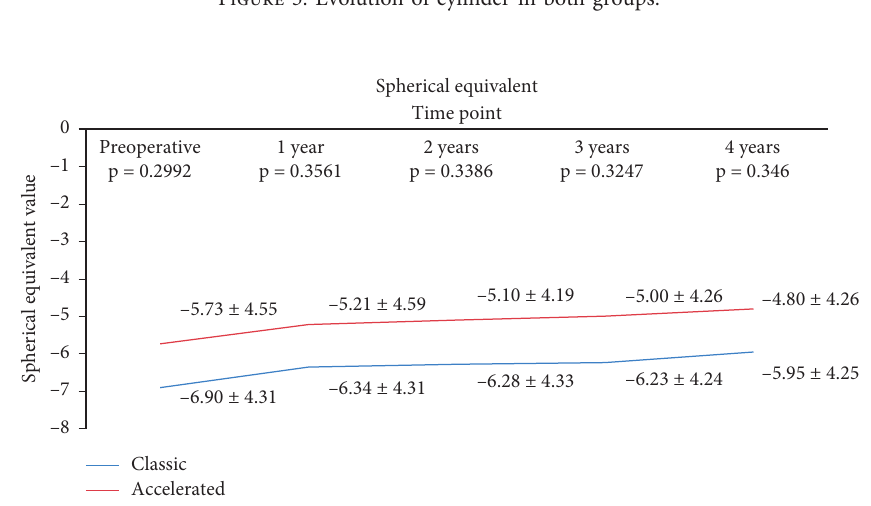
Figure 6: Evolution of SE in both groups.